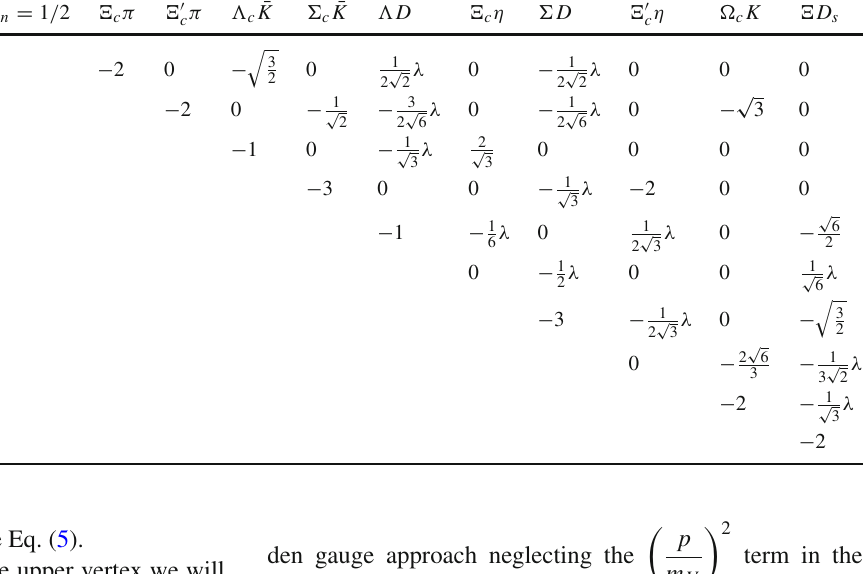
Table 7 D ij coefficients for the PB states coupling to J P = 1 / 2